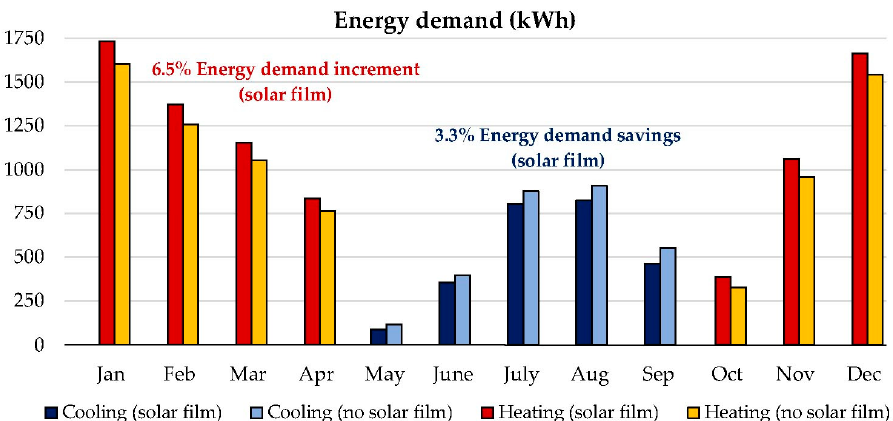
Figure 10. Monthly energy demand (kWh) of the cooling and heating systems in the rooms with and without solar protection film: with the existing 0.30 m cantilever. Source: Authors. Table 6. Cooling, heating and total annual energy demand of both cases. Source: Authors.